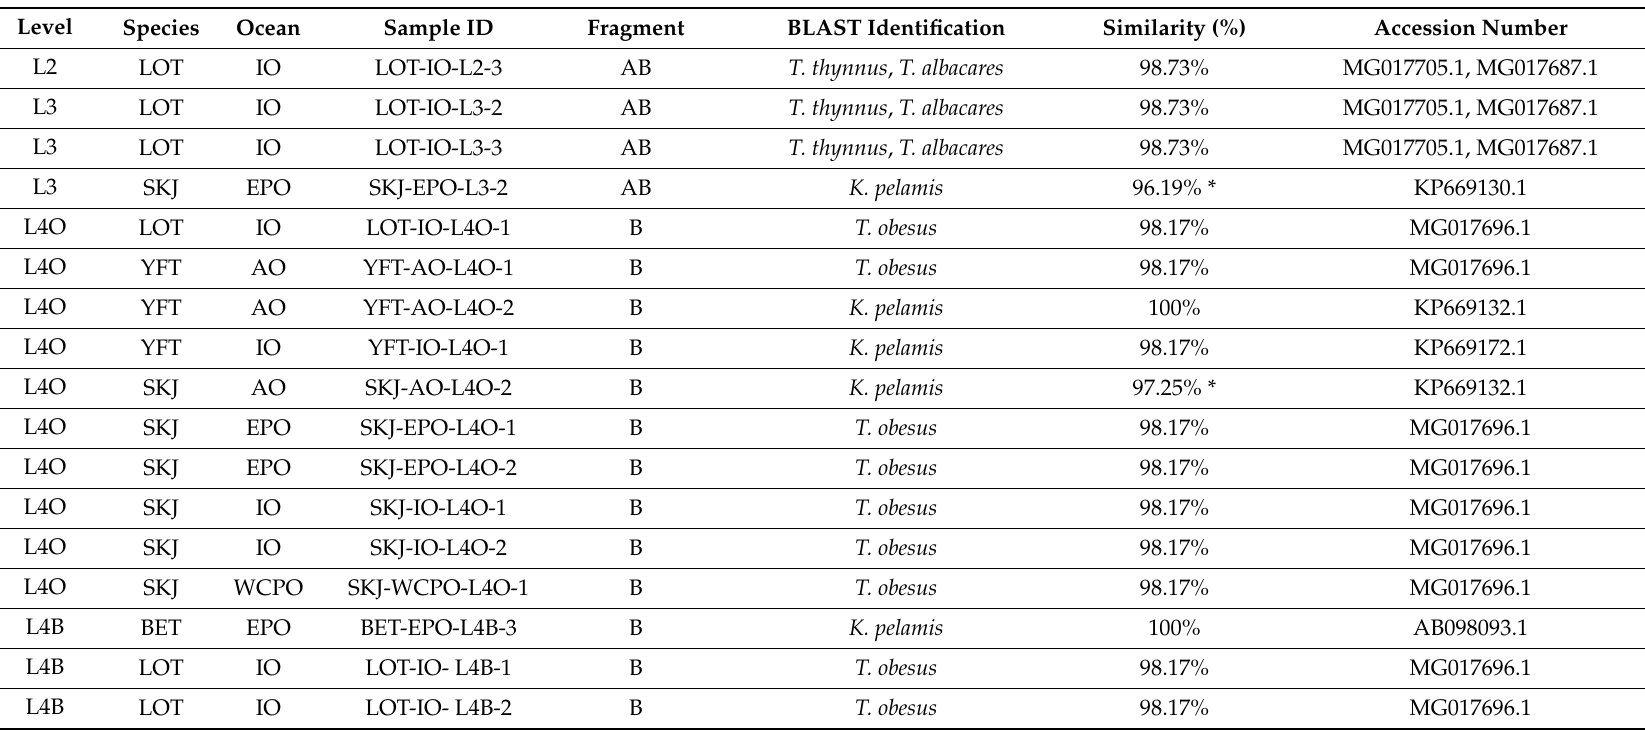
Table 2. Samples that were genetically misidentified at each processing level or had similarity scores < 98% (*). Yellowfin tuna: YFT, Bigeye tuna: BET, Skipjack tuna: SKJ, Longtail tuna: LOT. Atlantic Ocean: AO, Indian Ocean: IO, Western-Central Pacific Ocean: WCPO, Eastern Pacific Ocean: